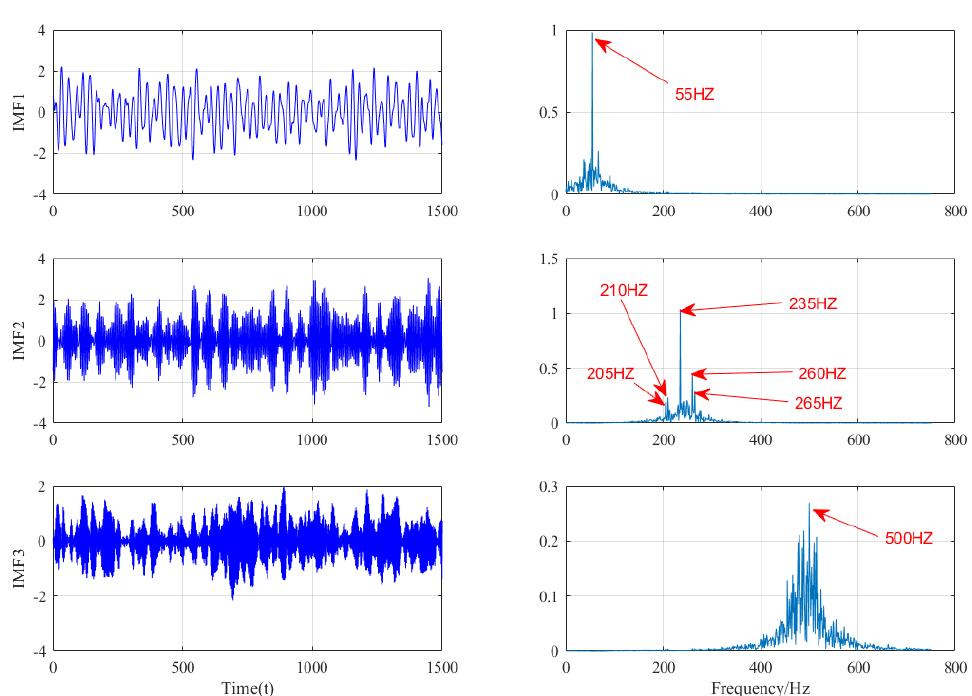
Figure 10. VMD decomposition results.